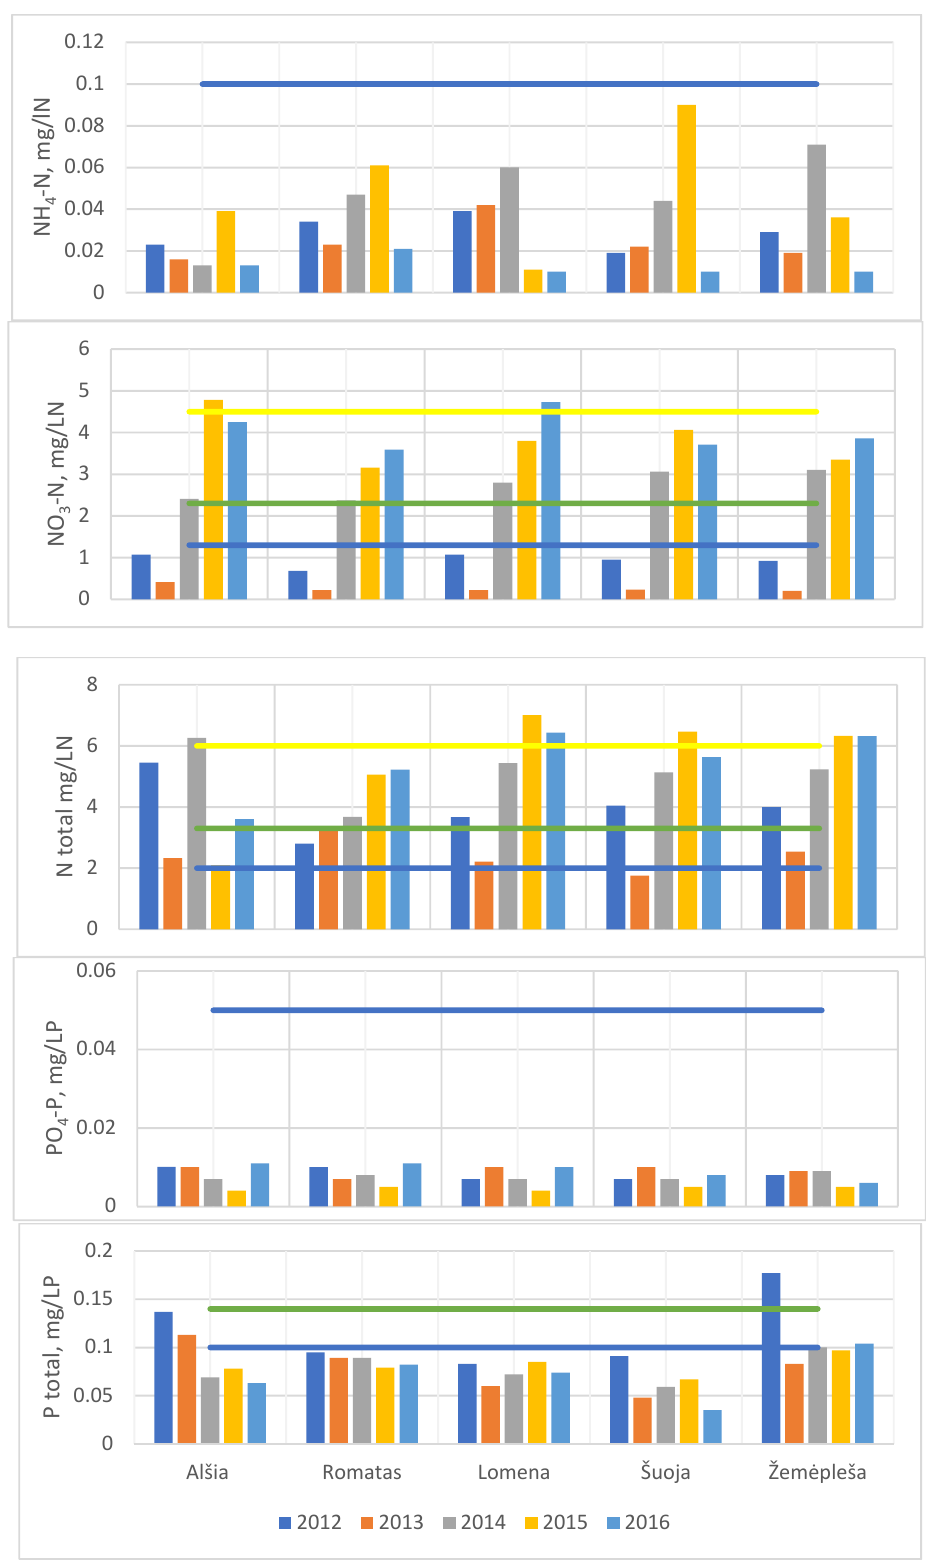
Figure 3. Ecological status of rivers according to the indicators of the physicochemical quality of elements.